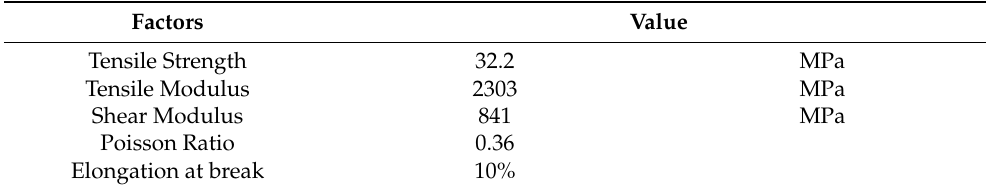
Table 4. Mechanical properties of EA 9309.3 NA epoxy adhesive